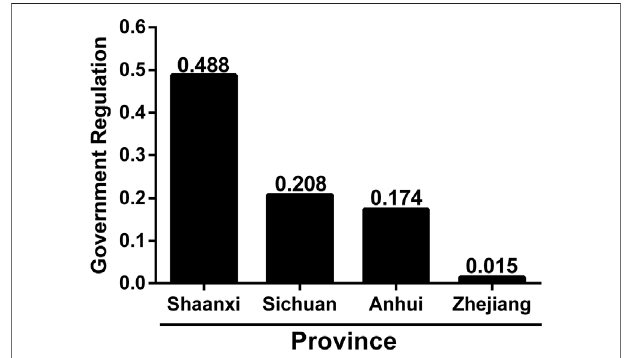
FIGURE 5 | The degree of government regulation in different